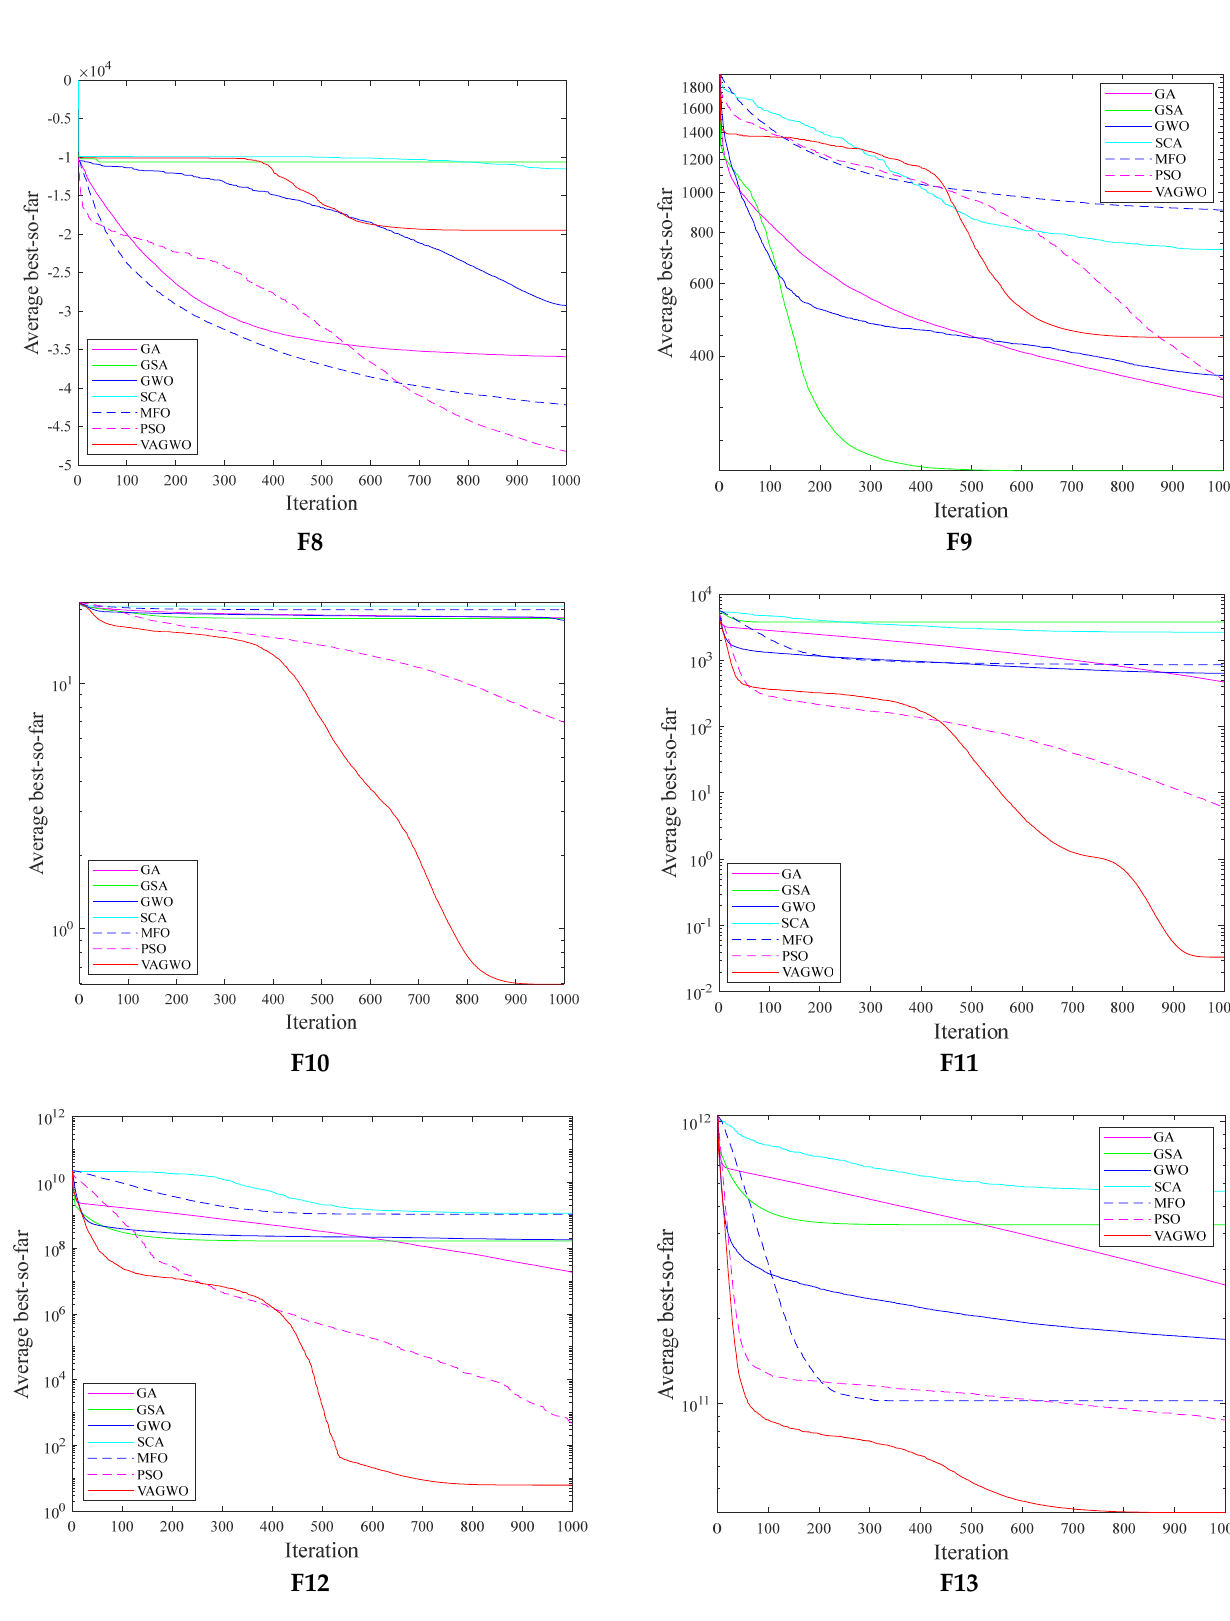
Figure 4. The convergence curves of the VAGWO and the popular algorithms for F8–F13.